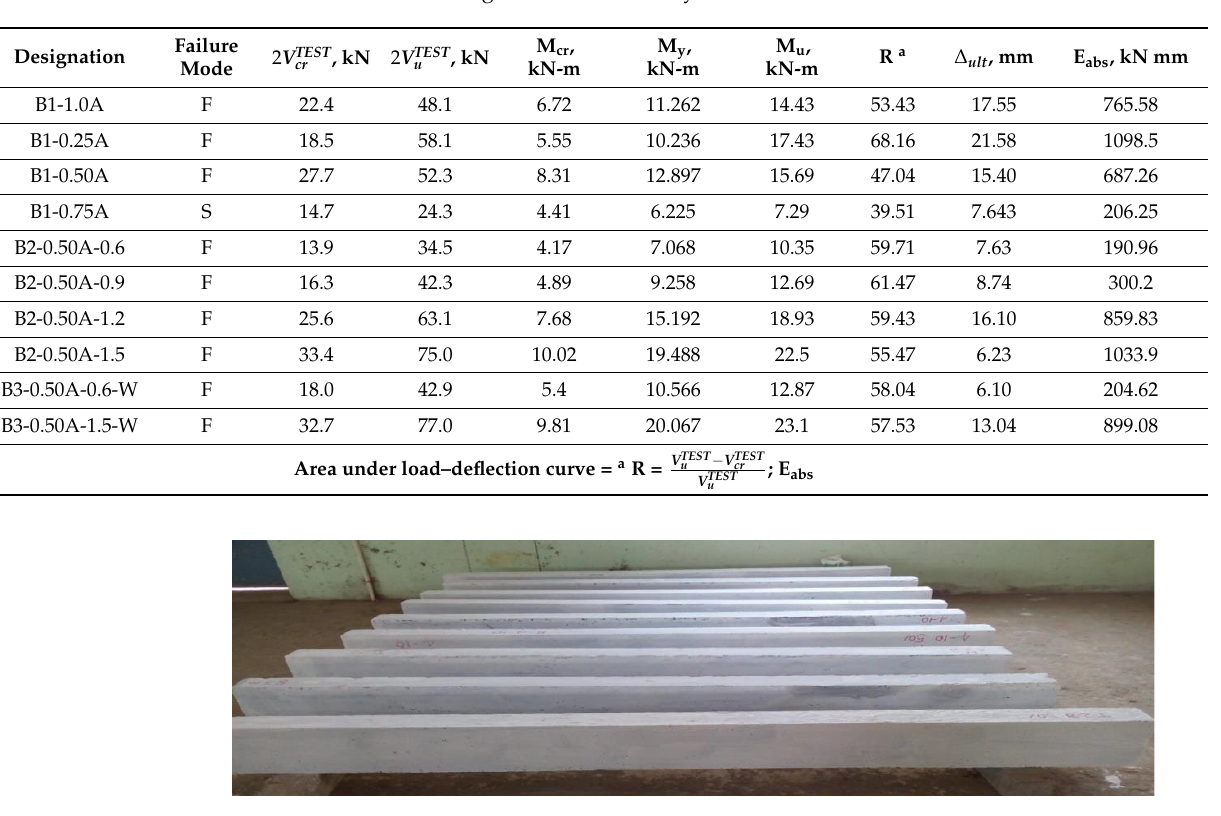
Figure 5. Cast specimens.